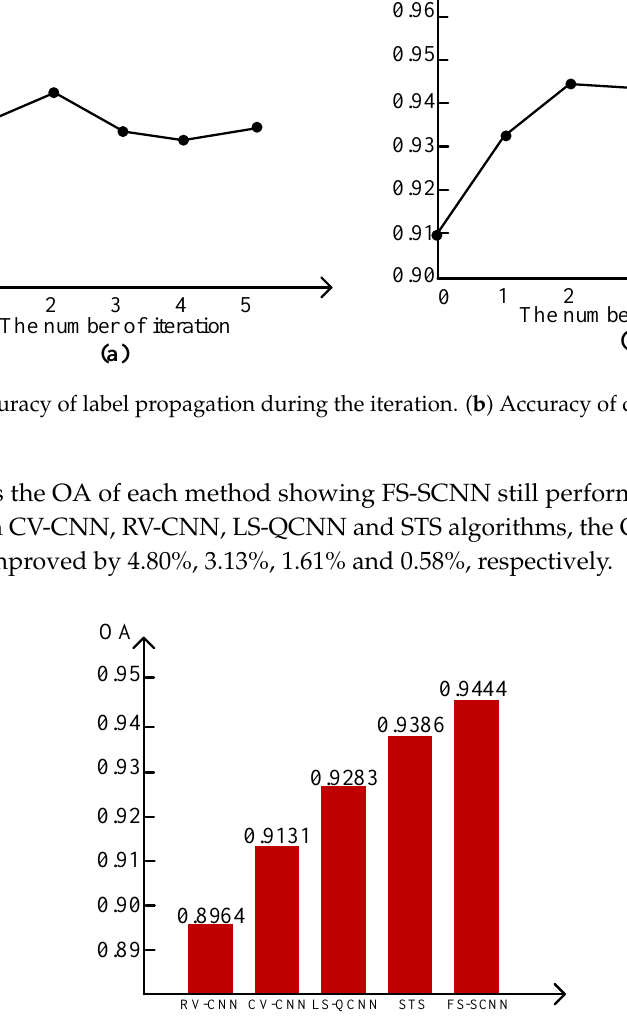
Figure 11. OA comparisons on